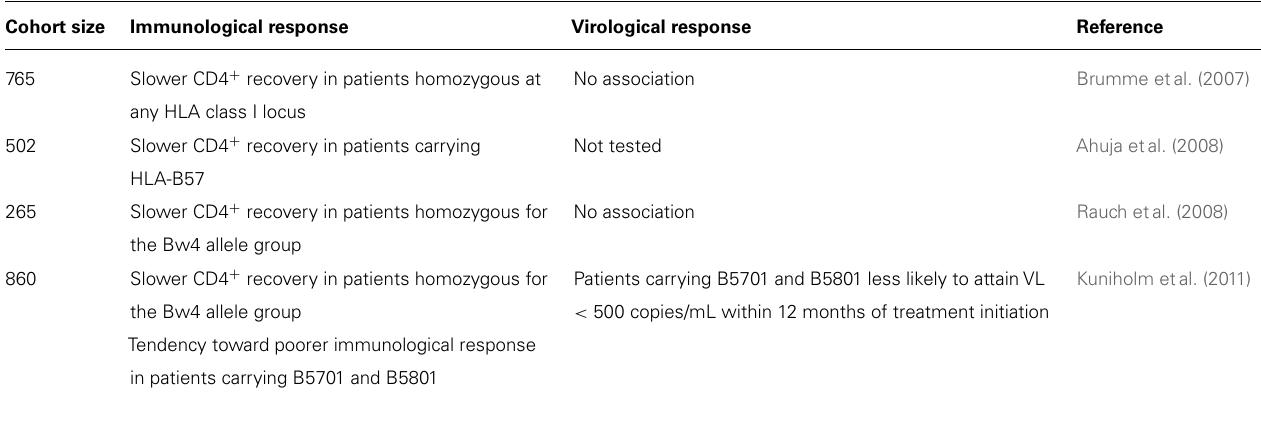
Table 1 | Reported associations between HLA alleles and immunological and virological response